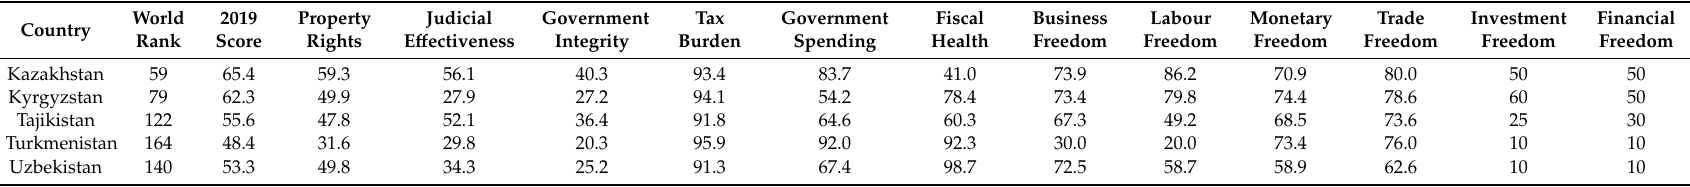
Table A3. Index of Economic Freedom 2019 (Source: author, based on Heritage Foundation, https: // www.heritage.org / index / explore?view = by-region-country-year).